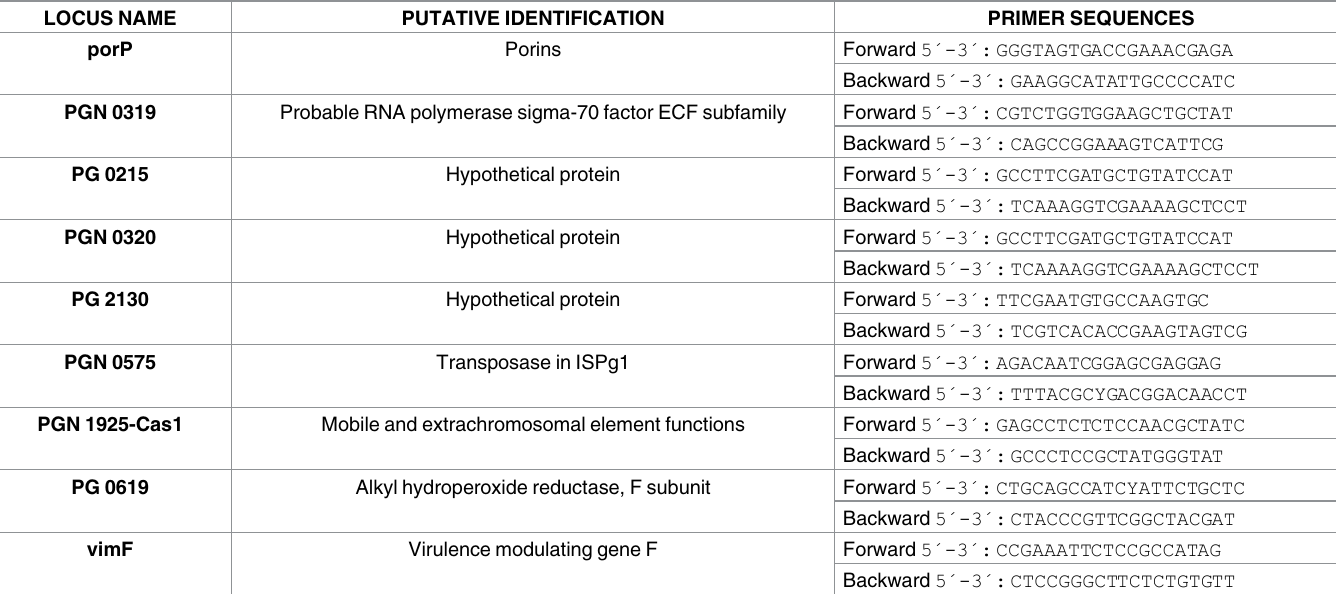
Table 1. Primers used for ReverseTranscription-quantitative Polymerase Chain Reaction